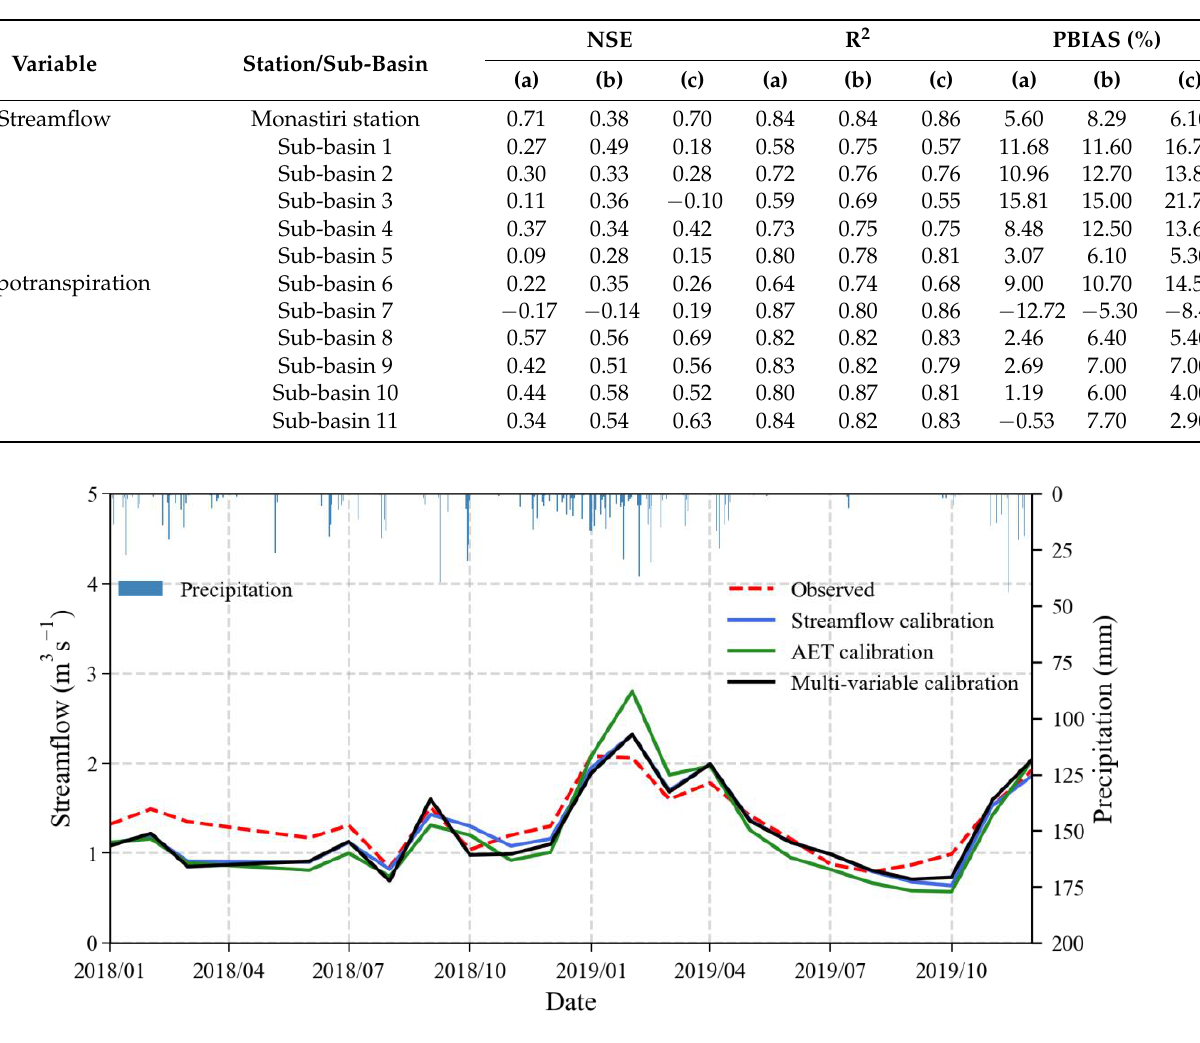
Figure 3. Simulated versus measured monthly streamflow for each calibration scenario at the outlet of the sub-basin (Monastiri gauging station).